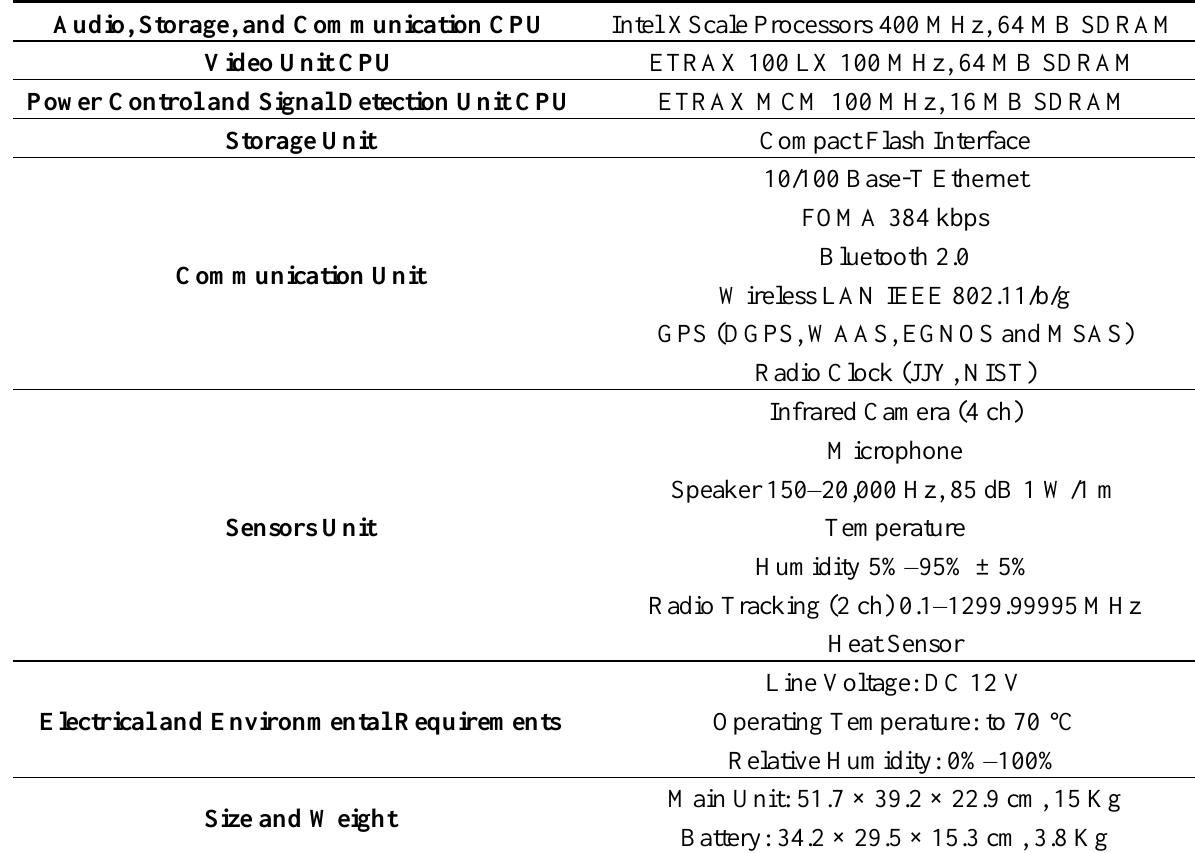
Table 1. Hardware